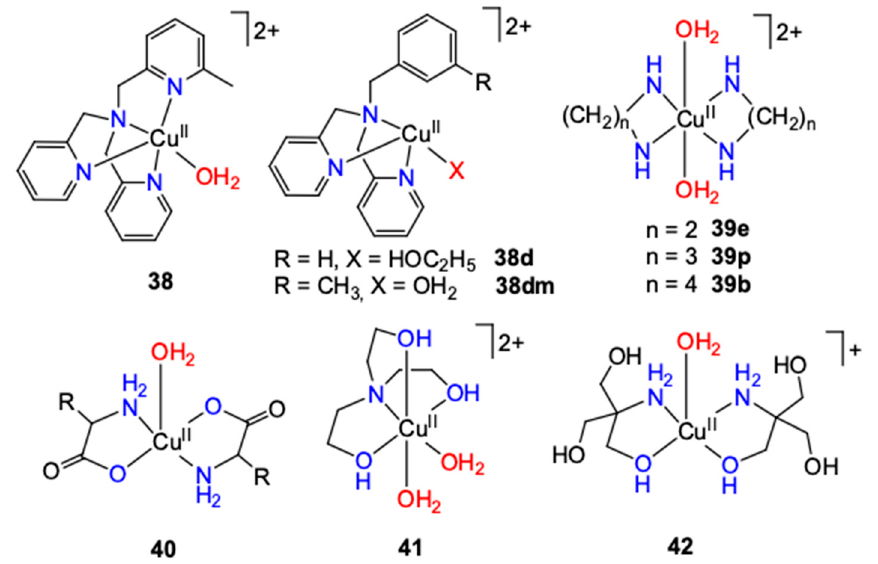
Figure 24. Precursor complexes.